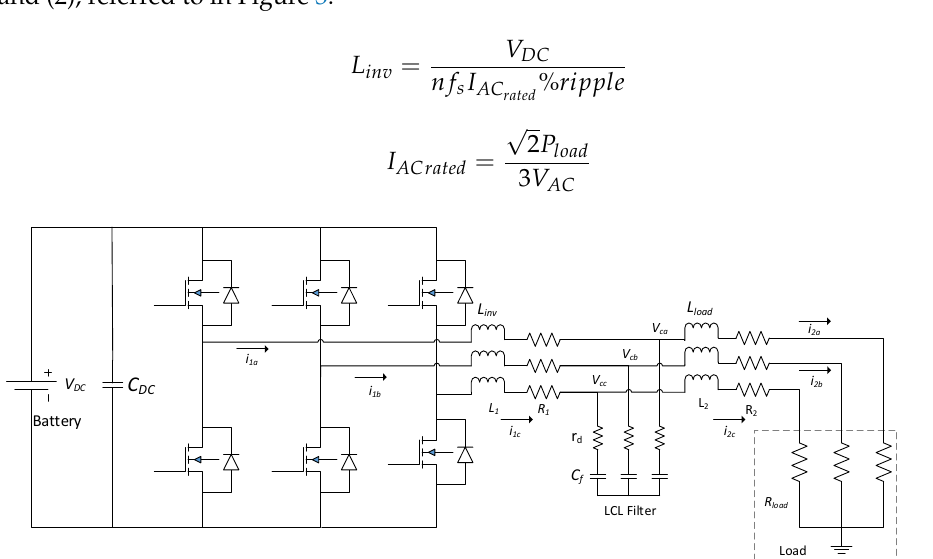
Figure 3. Passive filters of the inverter.